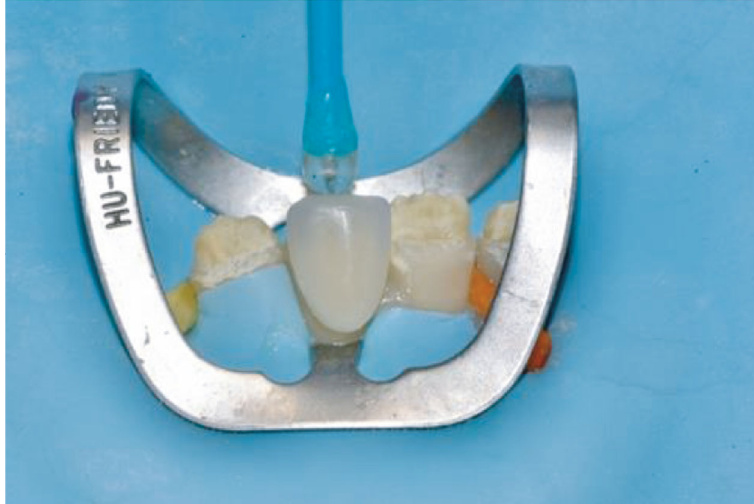
Figure 12: Veneer seated on the deserving tooth.